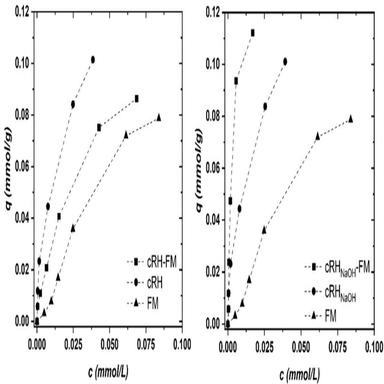
Lead ions adsorption isotherms of cRH, cRHNaOH, cRH-FM, cRHNaOH-FM, and FM. (Mass of adsorbent = 20 mg, volume of aqueous model solution = 10 mL, metal ion initial concentration between 0 and 50 mg/L (0.241 mmol/L), equilibrium pH between 6 and 7, T = 20◦C). The ions concentration is affected by an error lower than 4 % while that of the adsorption capacity is lower than 6 %. Lines are guides for the eyes.